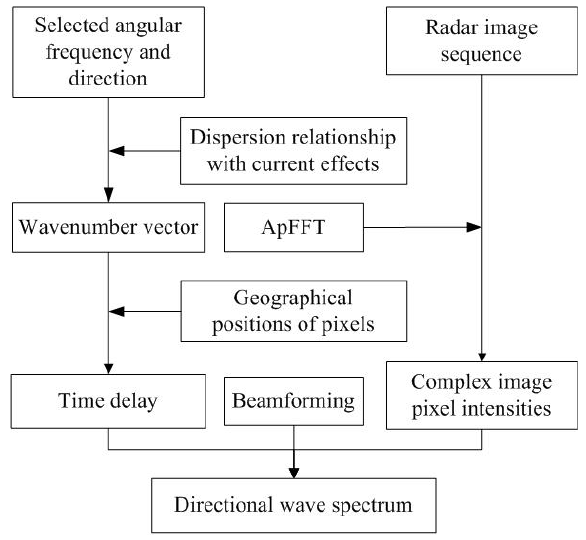
Figure 10. Basic steps of the array beamforming